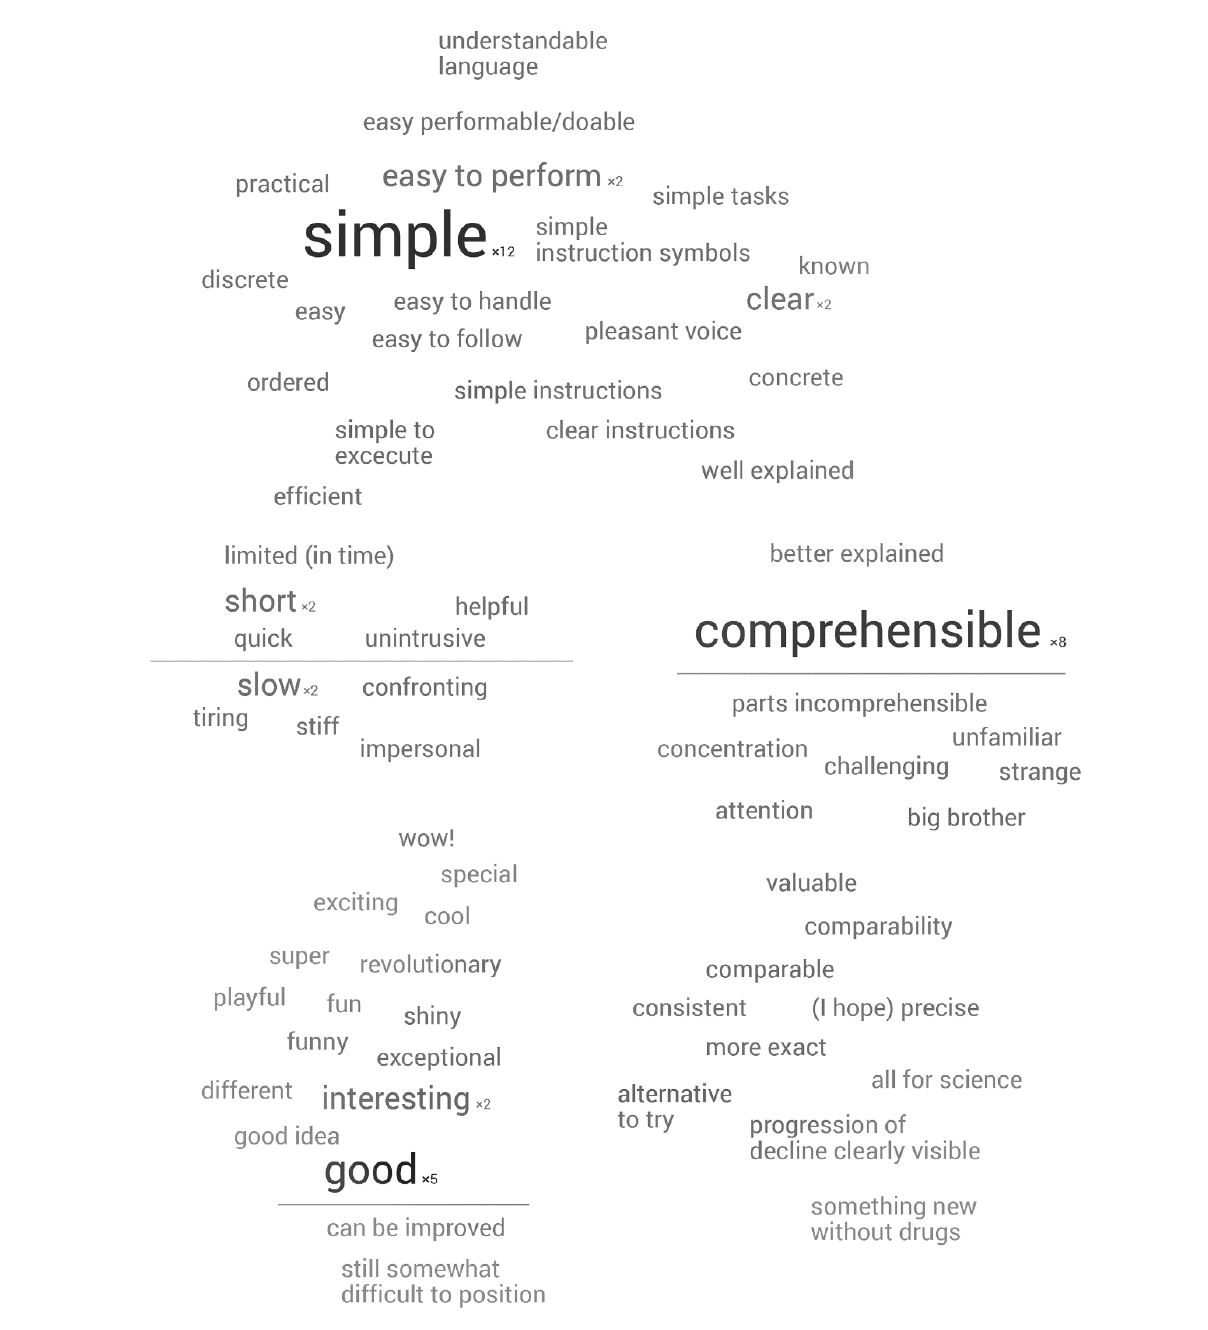
Figure 6. Word cloud of patientsâ€™ descriptive words of ASSESS